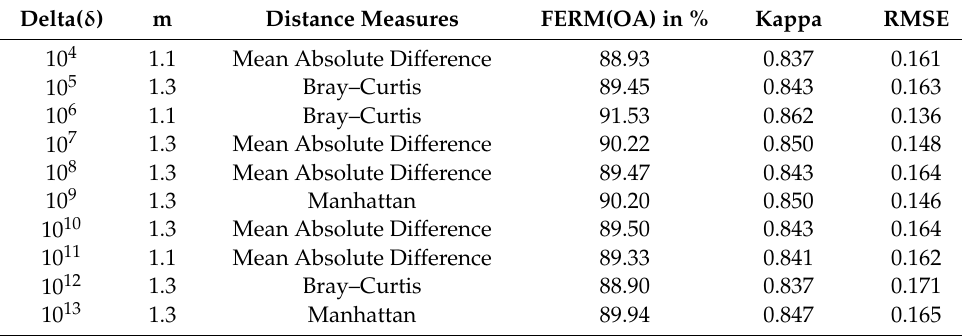
Table 4. Kappa and RMSE determined for the highest overall accuracy of the ADNLICM classifier by applying different parameters for site 1